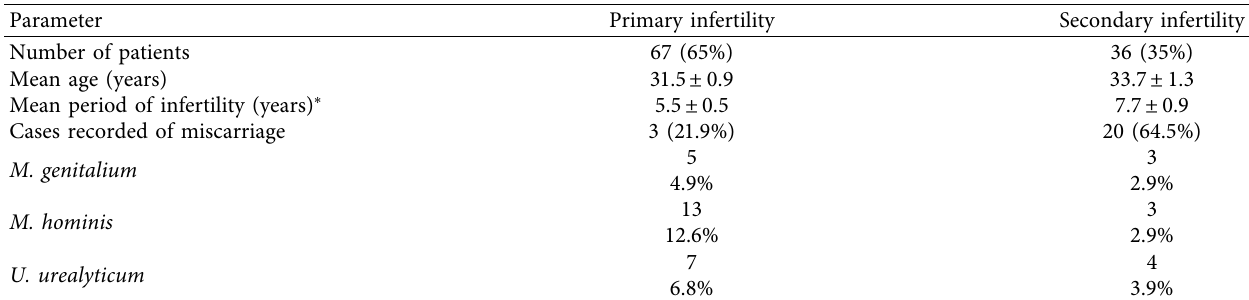
Table 3: Comparison between primary and secondary infertility in relation to Mollicutes infections.